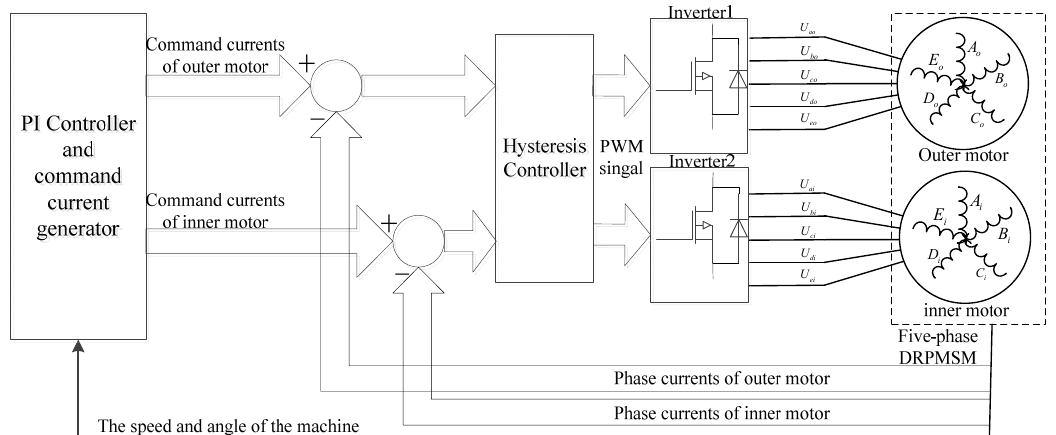
Table 4. The produced average electromagnetic torque and torque ‐ ripple under different fault types when machine operates in series driven mode. Operates under Different Conditions